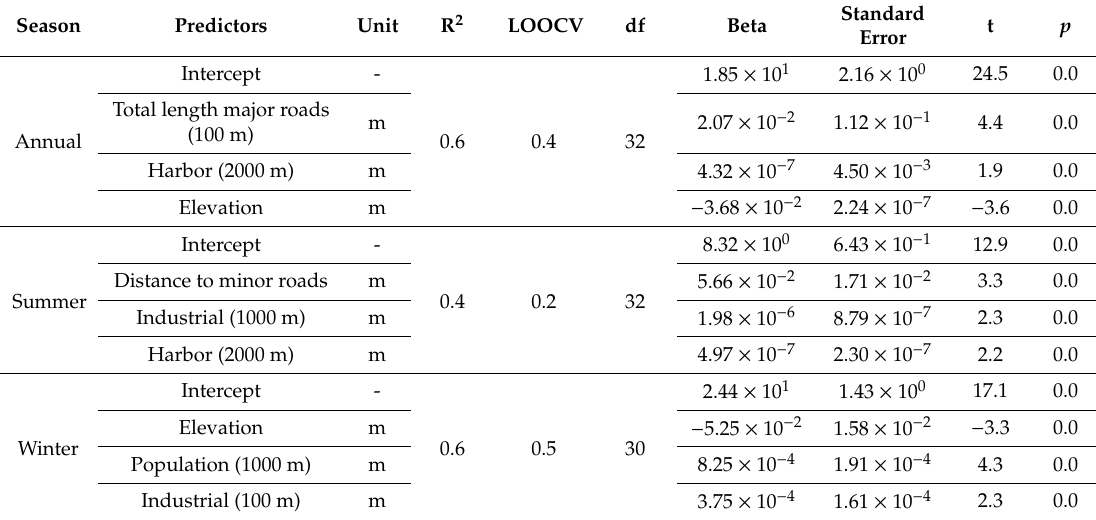
Table 2. Annual, summer, and winter NO 2 land use regression (LUR) model results.